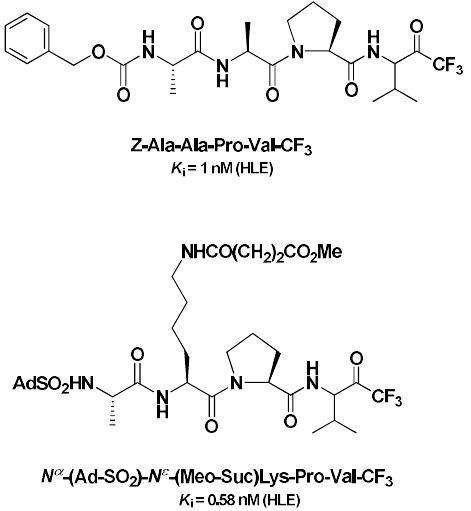
Figure 15. Chemical structures and K i values towards HLE of the two most relevant t-PFMKs developed by Peet N.P. et al.